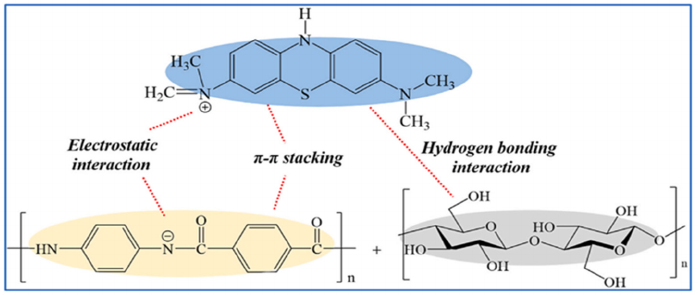
Figure 3. Adsorption mechanism of ANFS/BC aerogel on dye MB [102] .